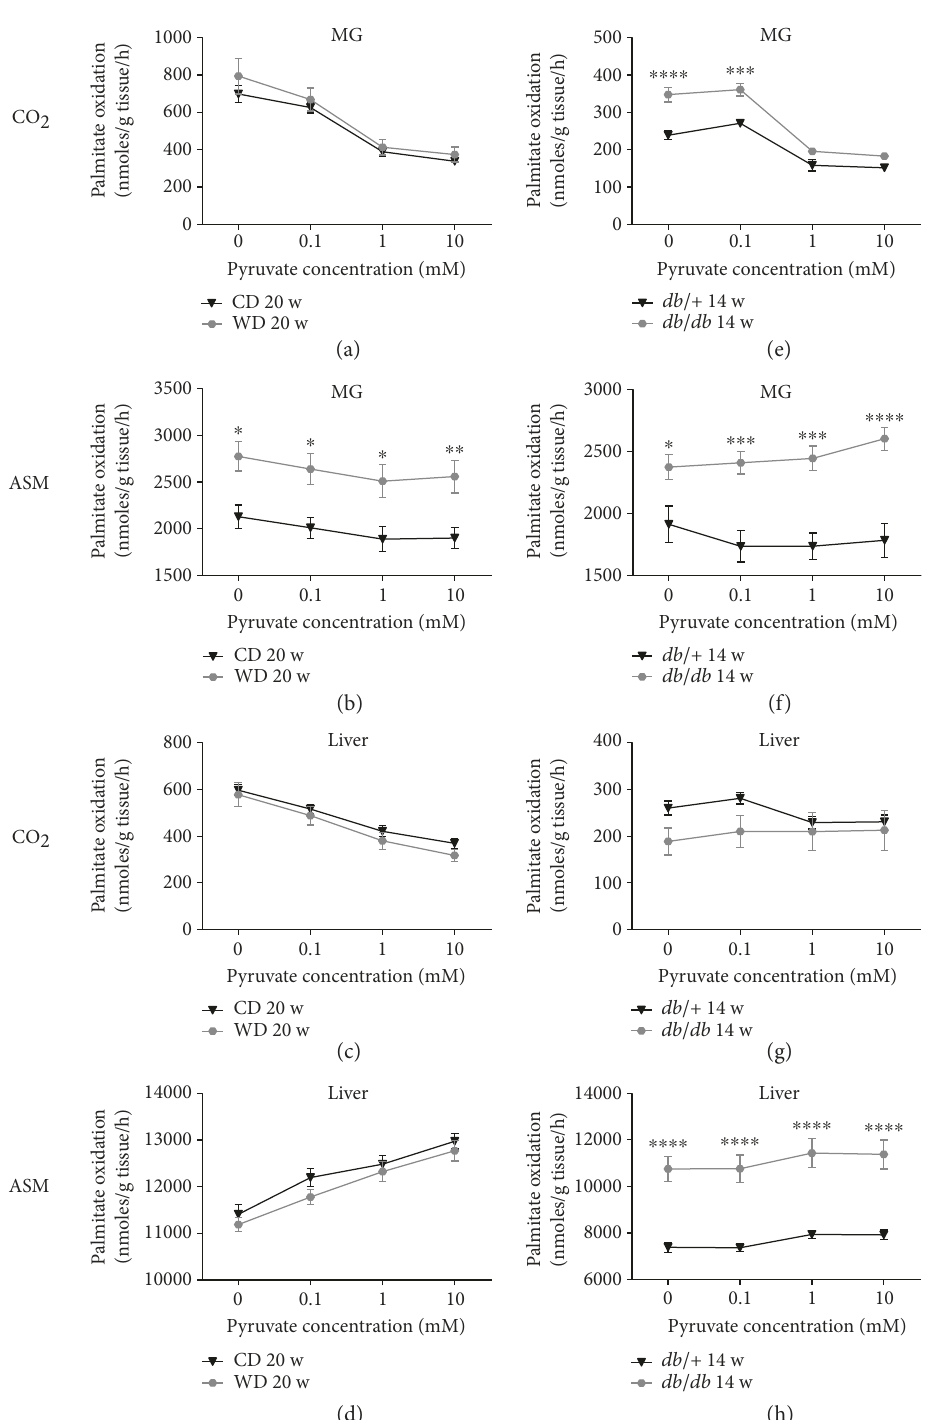
Figure 7: Derangements in the skeletal muscle and liver fat oxidation occur in db/db mice, while diet-induced obesity only negatively impacts skeletal muscle fat oxidation. Using [1- 14 C] palmitate (100 μ M), substrate switching was assessed by measuring complete (CO incomplete (acid soluble metabolite (ASM)) fat oxidation ± varying doses of pyruvate as a competing substrate. Assays were run using homogenates from mixed gastrocnemius (MG) skeletal muscle (a, b, e, f) and liver (c, d, g, h) from diet-induced (control diet versus Western diet for 20 weeks; a – d) and a genetically obese model ( db/+ versus db/db mice aged 14 weeks; e – h) of obesity. n = 8 per group; means ± SEM. ∗∗∗∗ p < 0 0001 versus control; ∗∗∗ p < 0 001 versus control; ∗∗ p < 0 01 versus control; ∗ p < 0 05 versus control by two-way repeated measures ANOVA with Bonferroni post hoc test for multiple